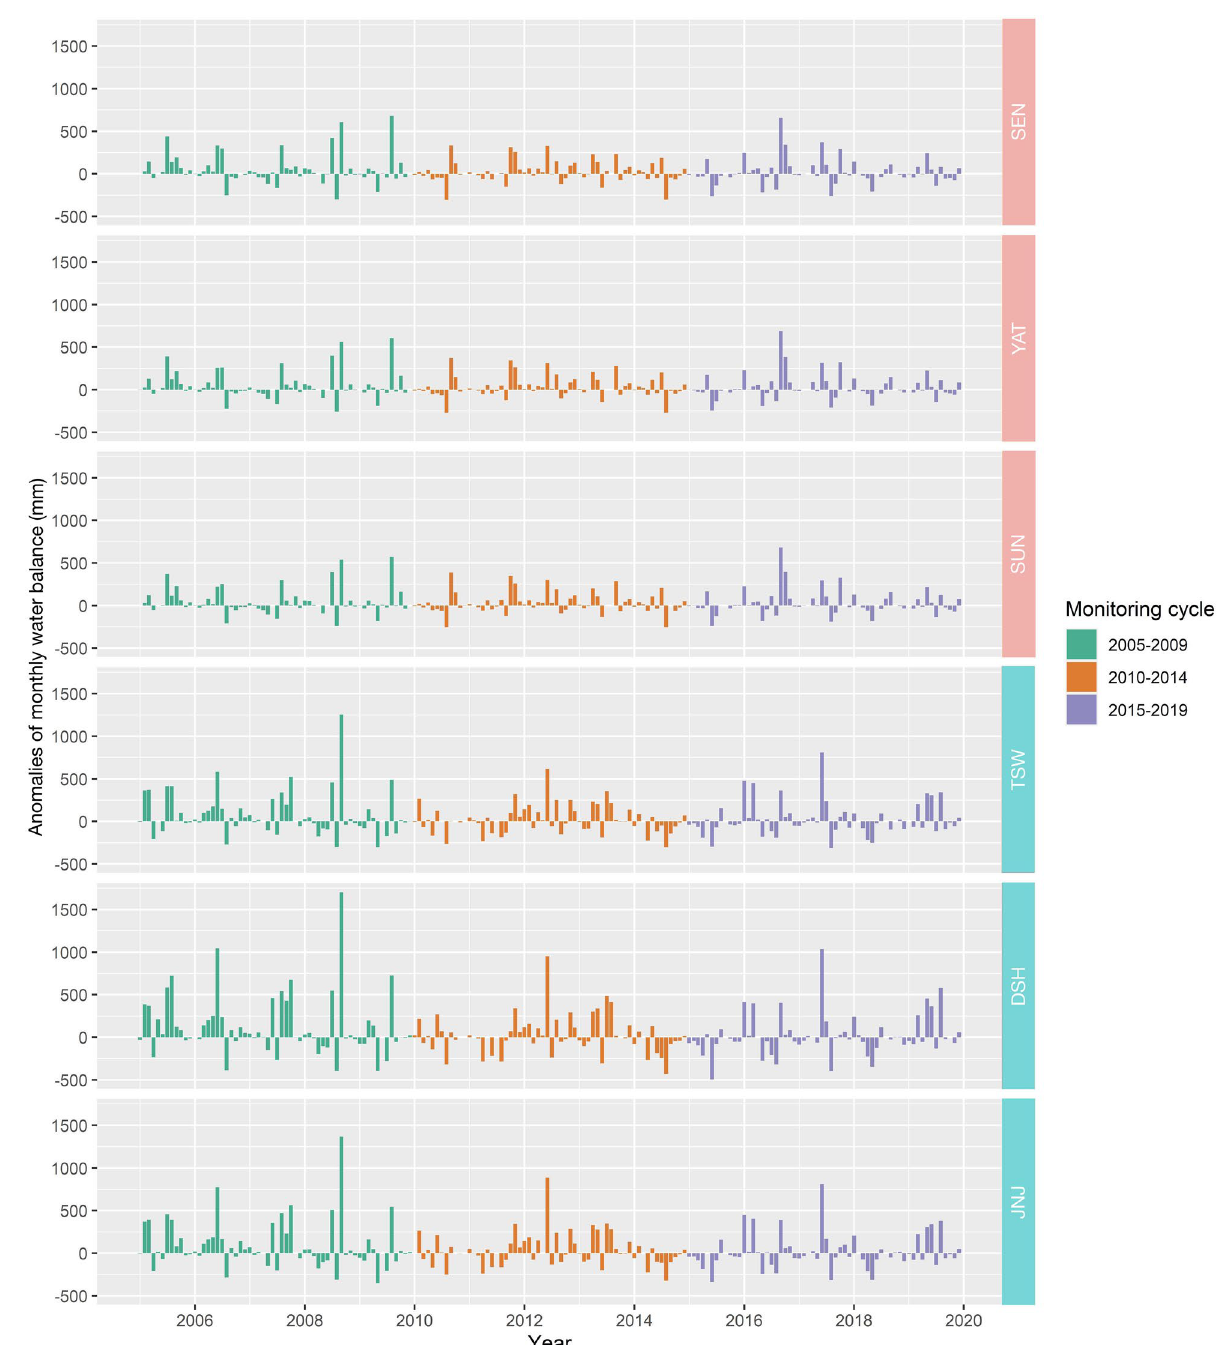
Figure 2. The monthly water balance anomalies in each summit during the monitoring periods from 2005 to 2019. The Dashueiku Mountain (DAS) region included SEN, YAT and SUN summits; the Syue Mountain (SYU) region included TSW, DSH and